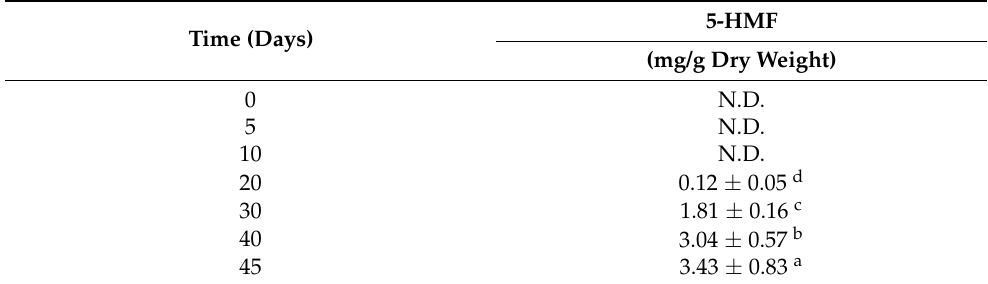
Figure 3. ( A ) Reducing sugar and ( B ) free amino acid contents of hot-water extract obtained from fresh garlic and black garlic with different aging durations. Values are shown as the mean ± S.D. ( n = 3). Different superscript letters indicate a significant difference ( p < 0.05). GE: glucose equivalent. Table 3. The 5-HMF content of hot-water extracts obtained from fresh garlic and black garlic with different aging